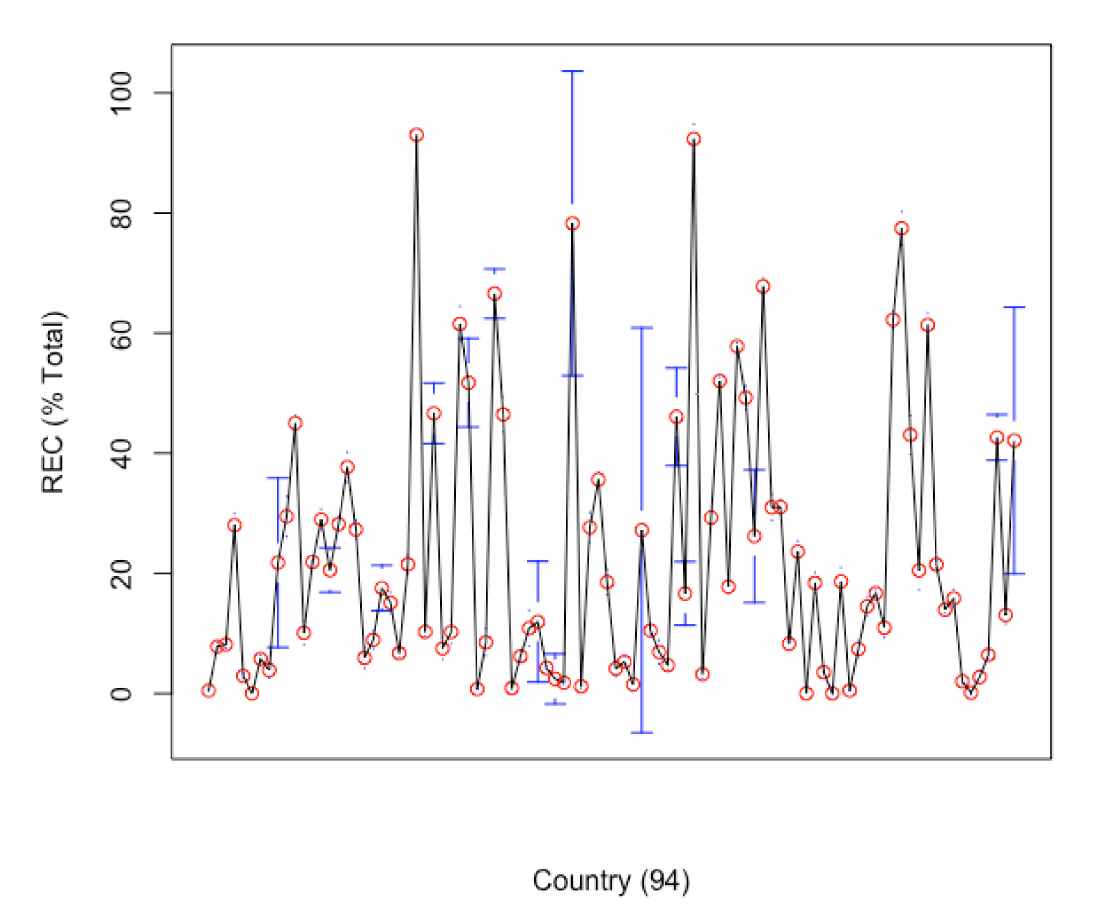
Figure 5. Mean level of REC (% of total energy utilization) by country, including the confidence interval. Source of data: World Bank’s Development Indicators (WDI)